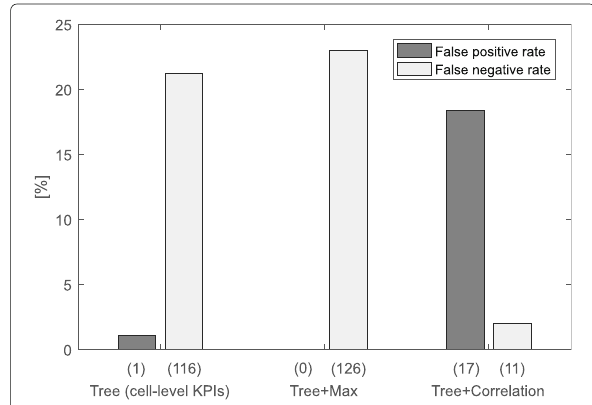
Fig. 11 False-positive and false-negative